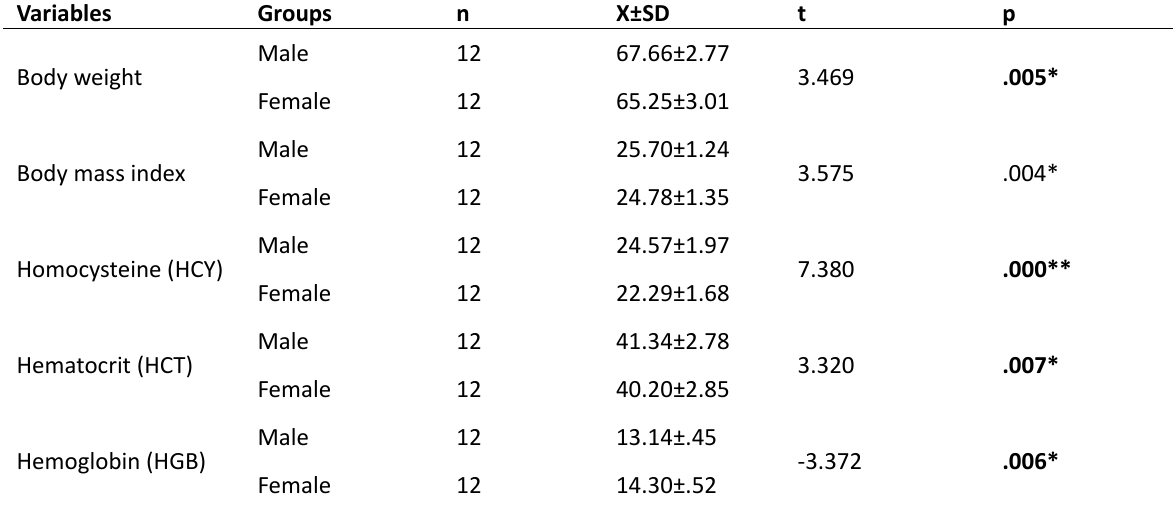
Table 5. Comparison of the pretest posttest values of the female participants